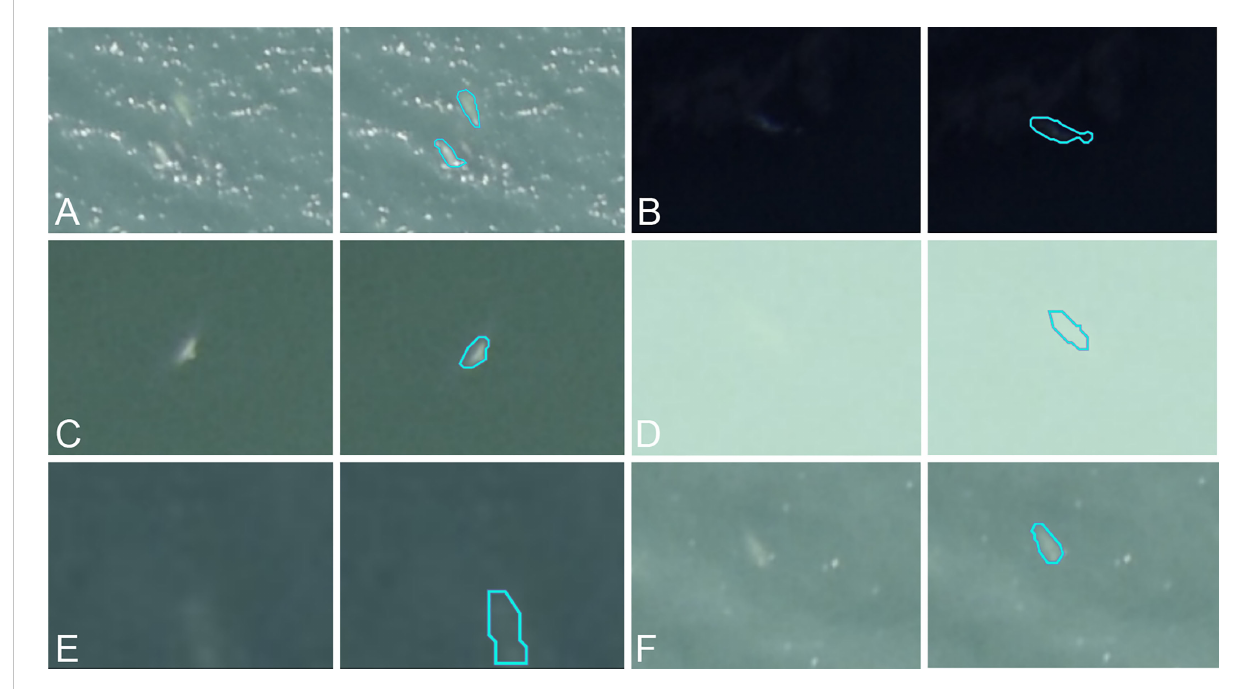
FIGURE 6 (A – F) Examples of predictions (original image on left, turquoise outline prediction on right) from iteration 2 identi fi ed as false positives for all three observers.